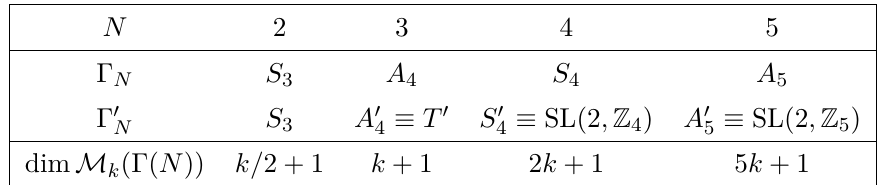
Table 1. Finite modular groups and dimensionality of the corresponding spaces of modular forms, for N ≤ 5 . Note that for N = 2 only even-weighted modular forms